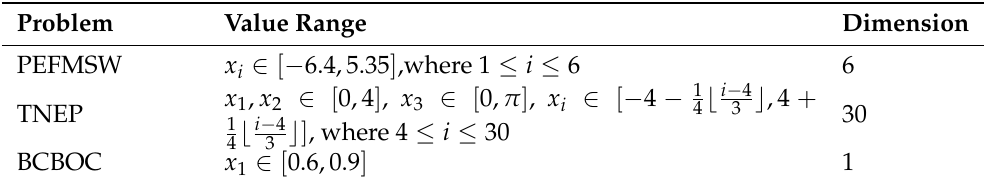
Table 7. The characteristics of three real-world